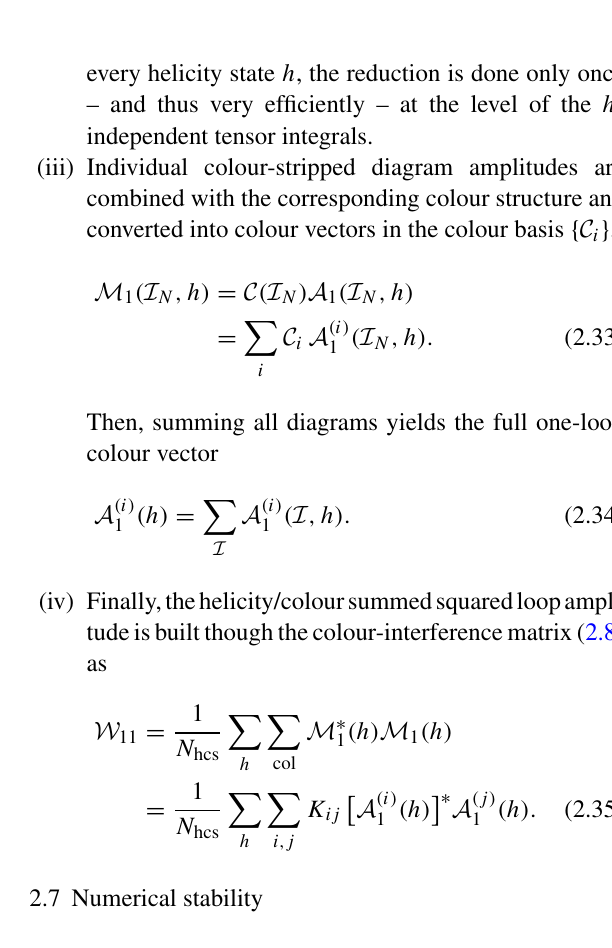
Fig. 3 Schematic representation of on-the-fly merging. Open loops with the same loop topology and the same undressed segments (grey blobs) are combined in a single object